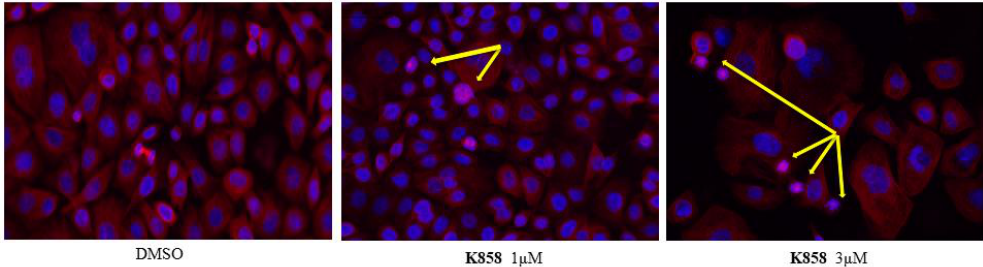
Figure 4. β-tubulin immunofluorescence analysis in AGS cell line treated with K858 for 24 h . AGS cells were treated for 24 h with 1 and 3 μM of K858 . Tubulin cytoskeleton was visualized following fixation by immunostaining, DNA was stained with 4’,6-diamidino-2-phenylindole (DAPI). After 24 h of K858 treatment the majority of AGS cells arrested in mitosis resulting in formation of monopolar spindle (yellow arrow).